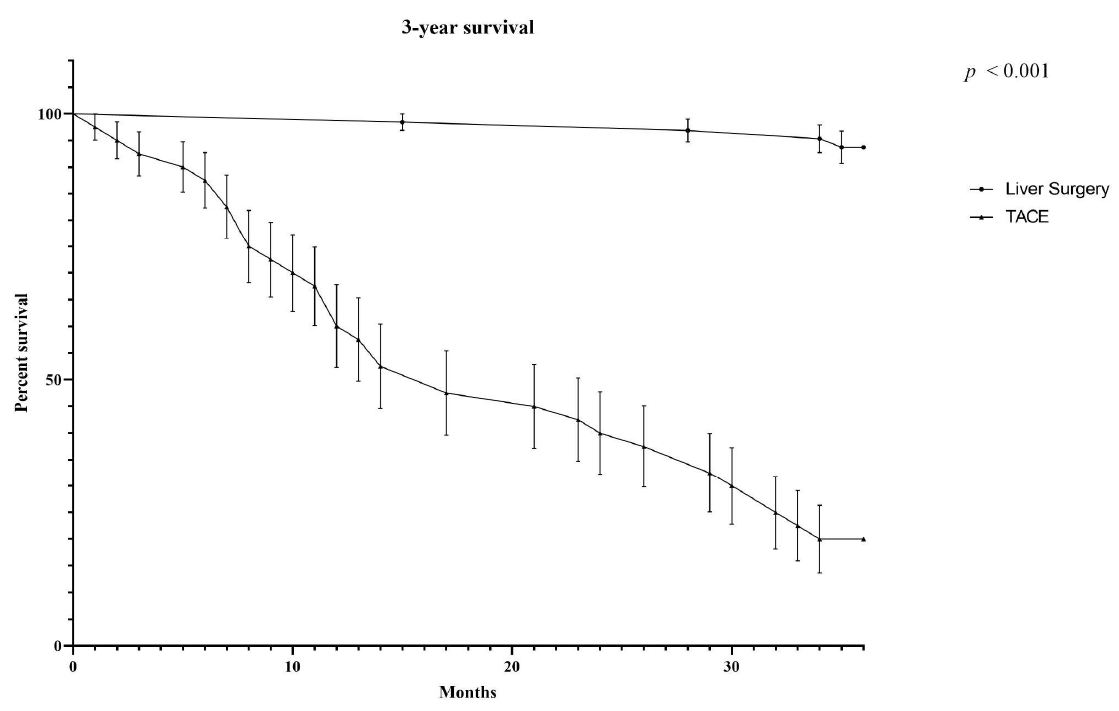
Figure 3. Comparison of OS between the surgical group and the TACE group. Nine resected patients did not reach 3-year follow-up; two were dead at 3 years: one due to HCC progression and one from other causes. In the TACE group, two patients did not reach the 3-year follow-up; a further 17 patients died within 3 years: seven due to HCC progression, three from hepatic failure, and seven due to other causes. Liver disease and HCC progression, the main causes of death, had a similar incidence in TACE patients; 26.3% and 28.9%, respectively. However, in HCC, the severity of the underlying cirrhosis may have influenced the overall survival, and it can sometimes be difficult to ascertain whether a given patient died from HCC or cirrhosis. 4. Discussion For a staging system to be effective and widely used, it has to be reliable, reproducible and simple, using data elements that can be obtained as part of standard clinical practice across a wide range of treatment options. The BCLC classification was first published in 1999 [39]. It was derived from a single institution experience, the Barcelona Clinic Liver Cancer group of experts, and approved during the single-topic conference of the European Association for the Study of the Liver (2000 EASL) [40,41]. The BCLC staging system takes into account the size and extent of tumor, liver function, and performance status, with a corresponding treatment schedule and expected survival estimation for each stage. It is considered the standard HCC staging system by the American Association for the Study of Liver Disease (AASLD) [42]. Since its introduction, the BCLC staging system, generated according to the results of randomized controlled studies, has been repeatedly validated and recommended for prognostic prediction and treatment allocation of HCC patients [8,15,43]. Nevertheless, with its repeated updating over time, surgical therapy has been confirmed for a restricted group of early solitary (0, A) HCC patients, and more recently single large tumors (>5 cm), with no vascular invasion or extrahepatic spread, are still considered surgical candidates and allocated as early HCC (BCLC-A). However, this category was estimated to have a worse prognosis than BCLC- A HCC <5 cm, and therefore some authors have suggested designating this subgroup as BCLC-AB or A1 stage [8,12,26]. The outcome of these cases is ill-defined, due to the scarcity of reports. Recent data have shown an improvement in OS with resection compared to TACE [17–26,44,45].